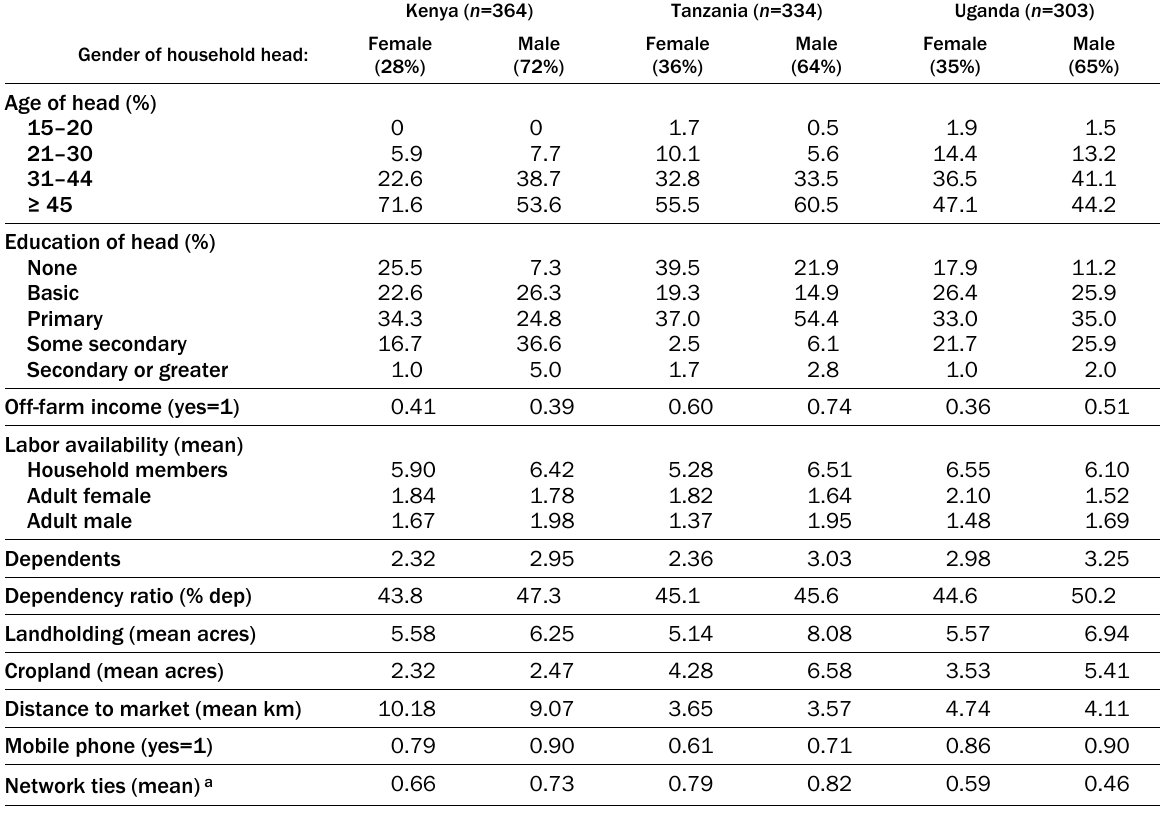
Table 3. Sample Descriptive Statistics by Country and Gender of the Household